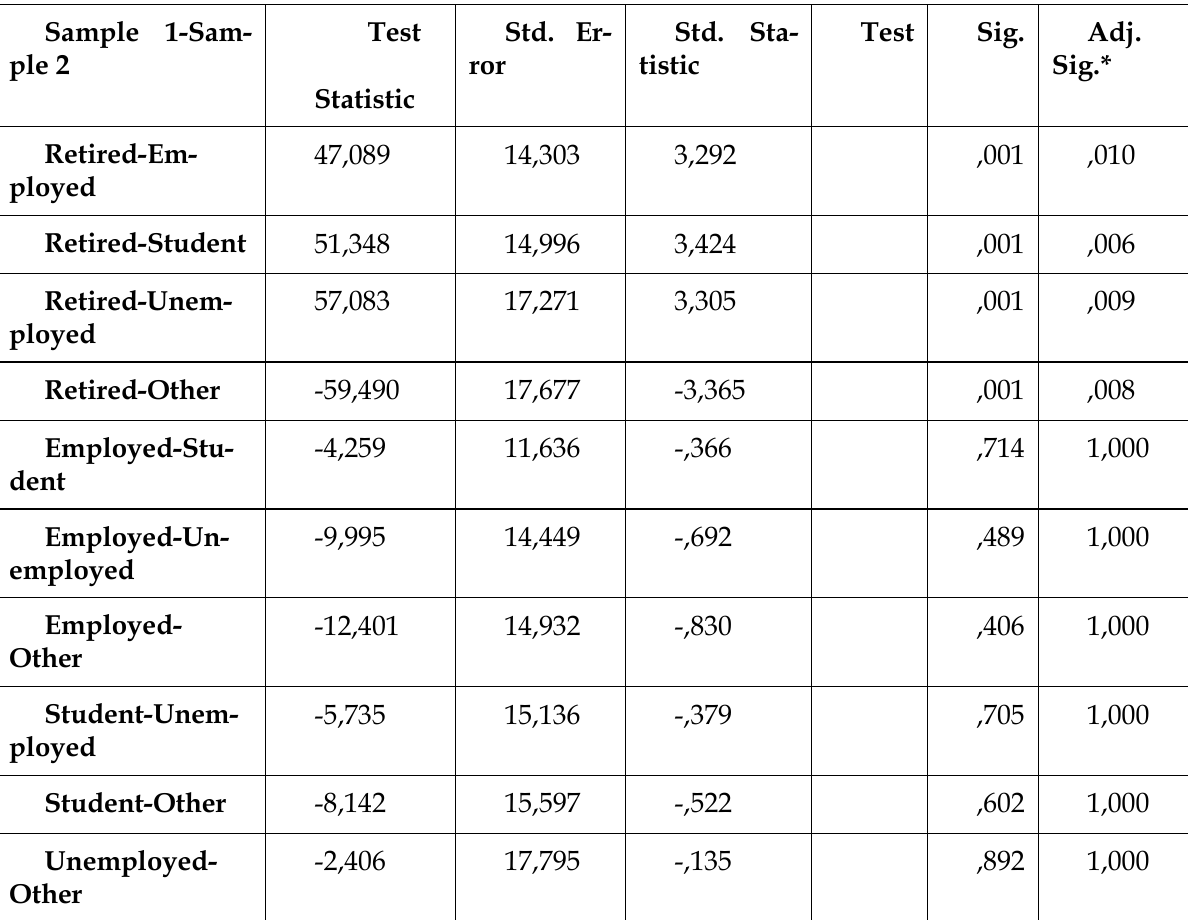
Table 30. Willingness to use the Digital Health Centre and occupation. Pairwise comparison (Bonferroni). Each row tests the null hypothesis that the Sample 1 and Sample 2 distributions are the same. Asymptotic significances (2-sided tests) are displayed. *Significance values have been adjusted by the Bonferroni correction for multiple